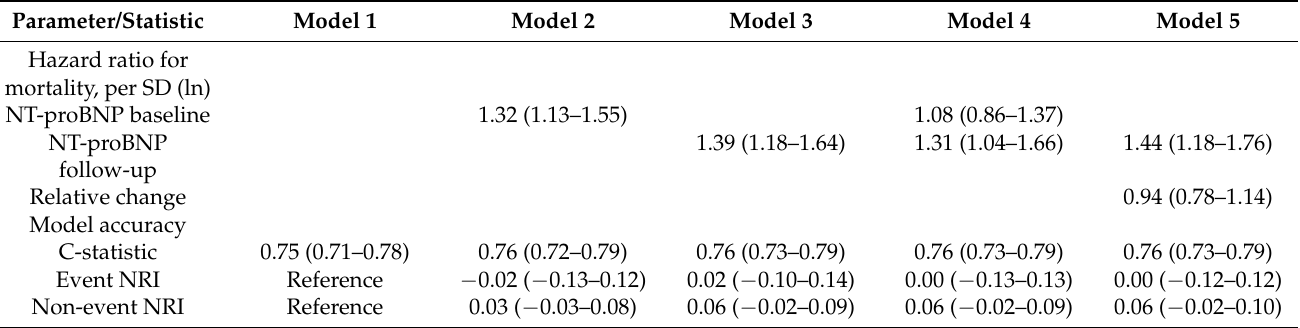
Table 3. Cox proportional hazard models for mortality ( n = 347, 209